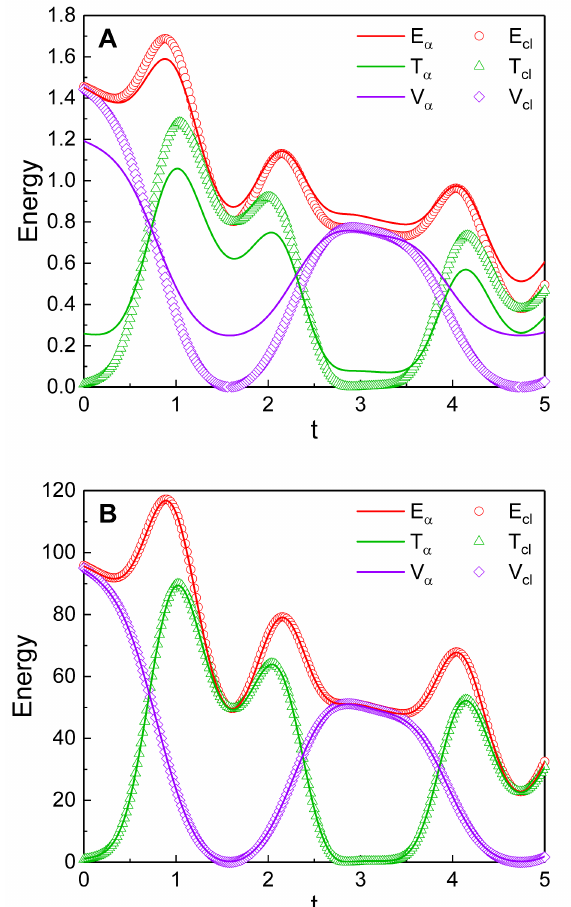
Figure 4. Comparison of the quantum energy with the classical energy for a low ( A ) and a relatively high ( B ) amplitude regime. E α , T α , and V α are the total quantum energy, the quantum kinetic energy, and the quantum potential energy, whereas E cl , T cl , and V cl are the total classical energy, the classical kinetic energy, and the classical potential energy, respectively. The taken values of ( α 0 , A 0 , f d ) are (1, 1.74, 1) for ( A ) and (10, 14.2, 10) for ( B ). Other values that we have used are γ e = 0.2, ω e = 1, ϕ = 0, m = 1, ¯ h = 1, and ω =